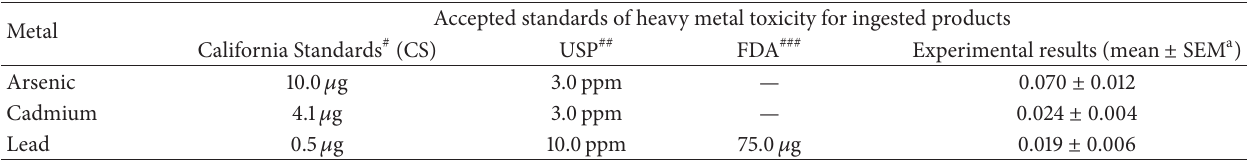
Table 4: Tolerable daily intake of heavy metals in ingested